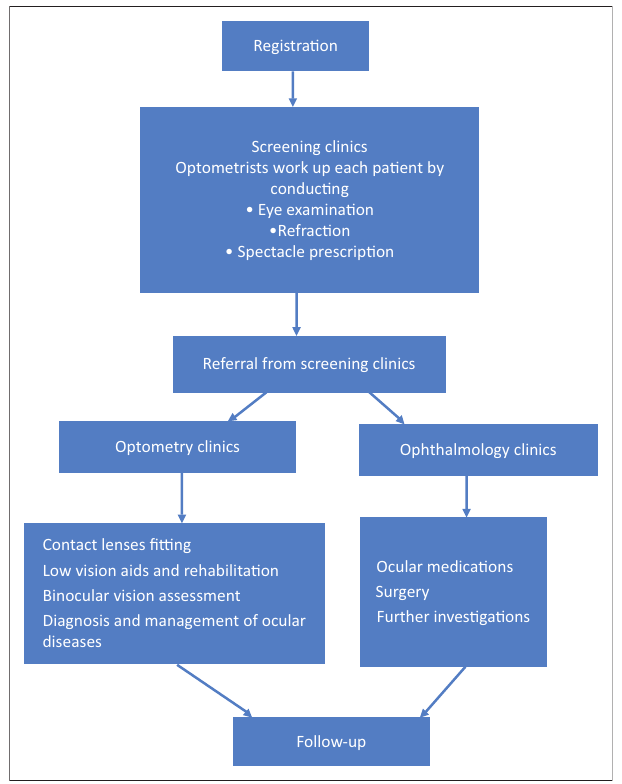
FIGURE 4: New work flow pattern suggested for Saudi Arabian public eye